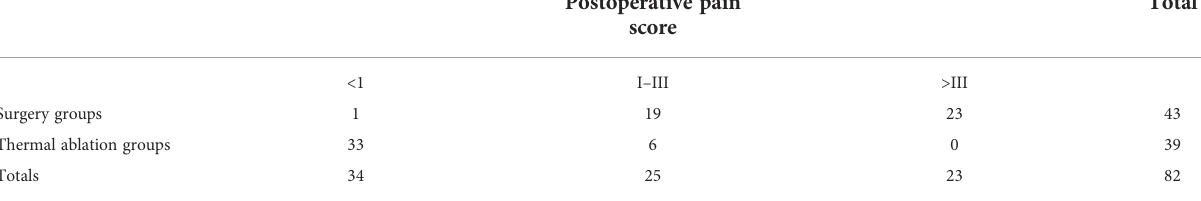
TABLE 7 Comparison of postoperative pain degree between two groups.